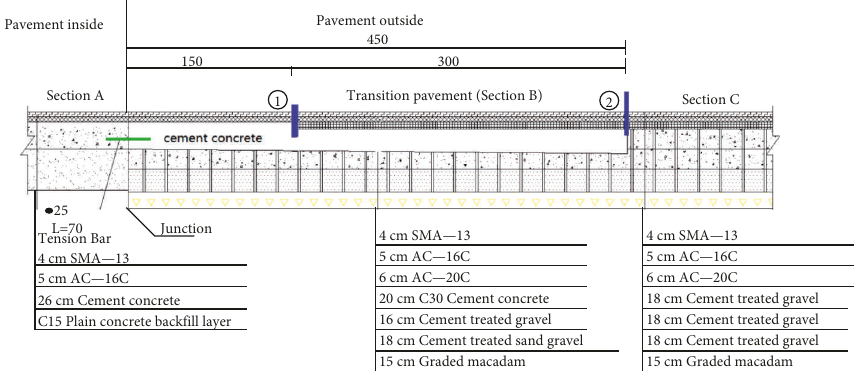
Figure 8: Pavement structures in the entrance and exit sections of the Huangjiayu tunnel (Str-1).